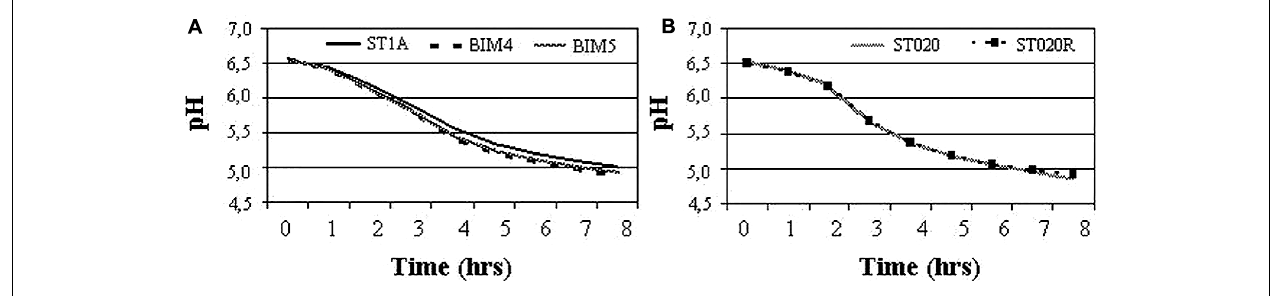
FIGURE 4 |Acidification profiles of the phage-resistant strains BIM4 and BIM5 produced at the pilot plant as frozen pellets, compared to that of frozen pellets of the phage-sensitive strain ST1A (A). Acidification performance of the blend ST020R containing the BIM5, compared to that of the phage-sensitive blend ST020 (B)